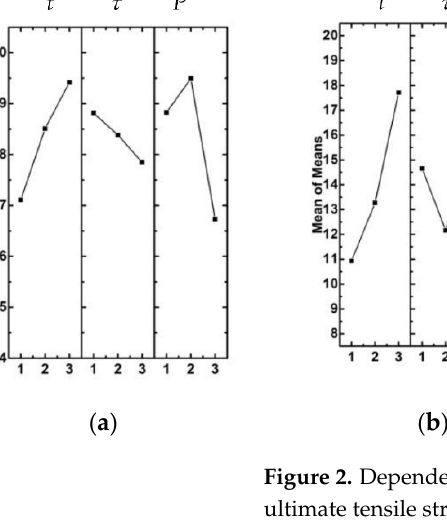
ultimate tensile strength ( a ), elongation at break ( b ), work of strain ( c ), and USW joint thinning ( d ).